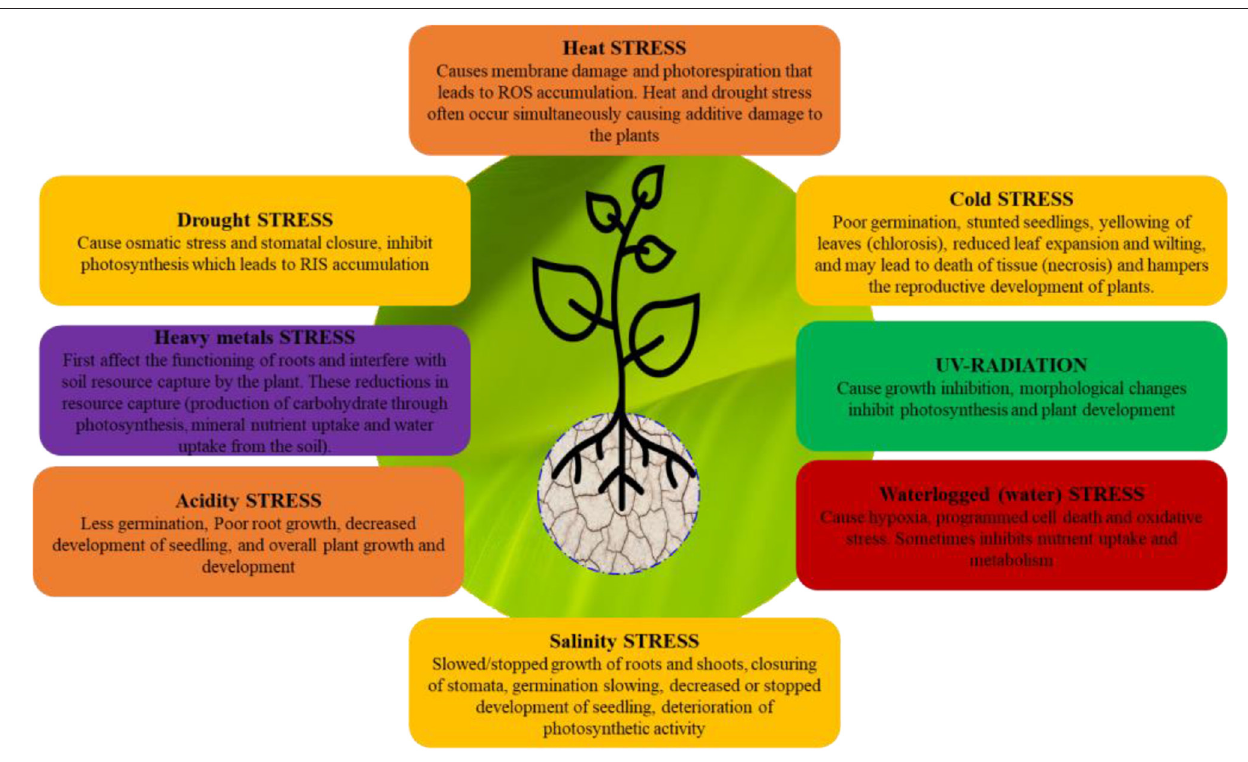
FIGURE 2 | Overview of abiotic stress and effects on plant growth and